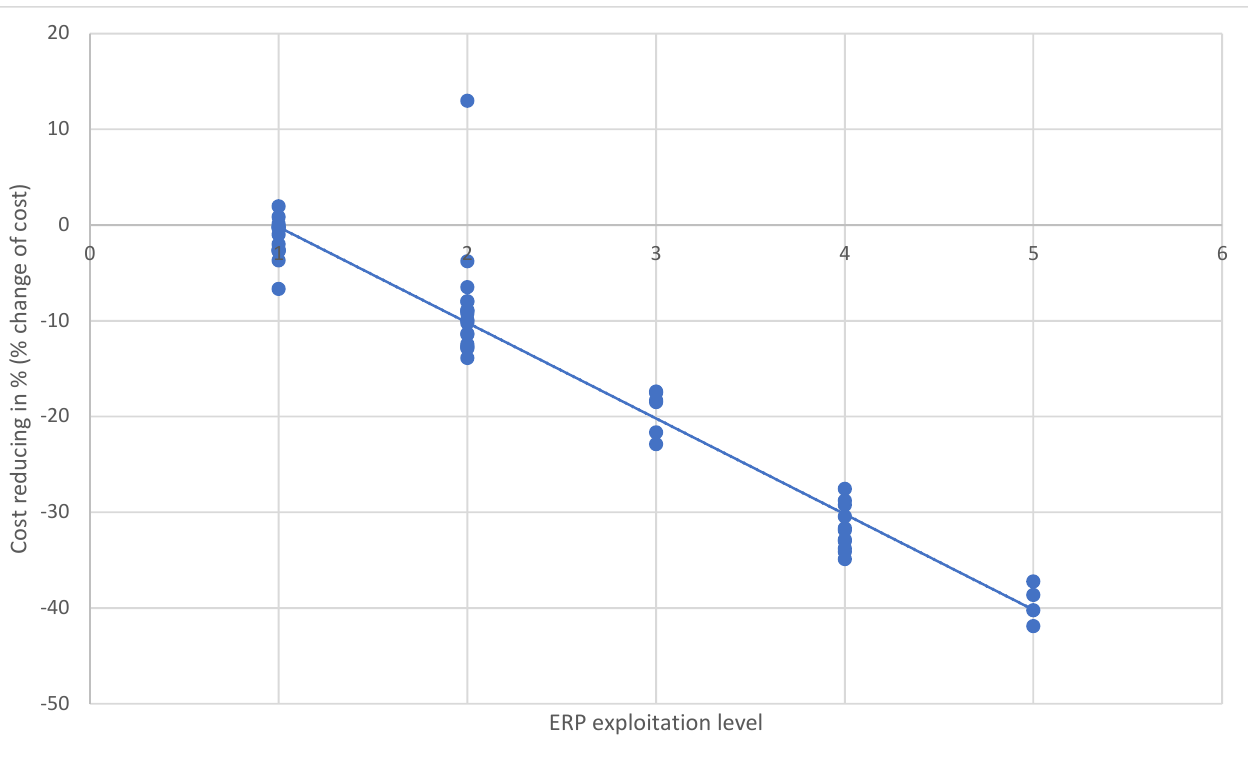
Figure 5. Correlation between the examined variables (ERP exploitation level and cost savings in percentages = percentage change in cost).